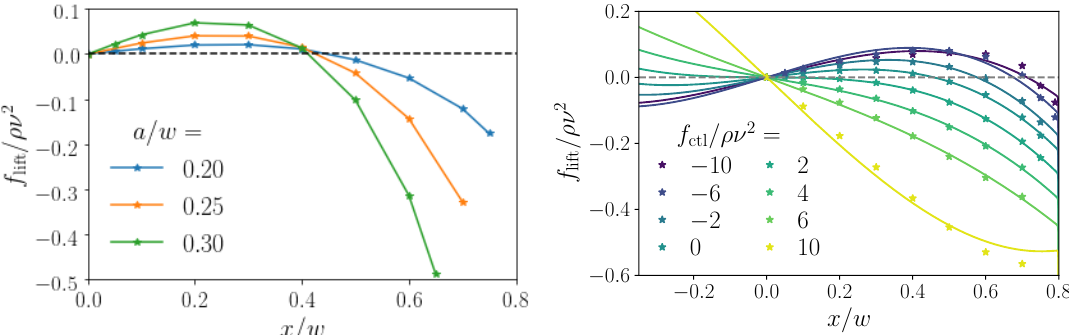
Figure 2. ( Left ): lift-force profiles along the positive x axis for different particle radii a / w at zero axial control force, f ctl = 0. Note the larger strength of the lift forces for larger colloids and the shift of the stable fixed point. The force unit ρν 2 uses fluid density ρ and kinematic viscosity ν = η / ρ . ( Right ): lift-force profiles for a colloid with radius a = 0.2 w at different axial control forces and least-square fits using Equation (4) (solid lines). In both cases, the Reynolds number Re = 10 is